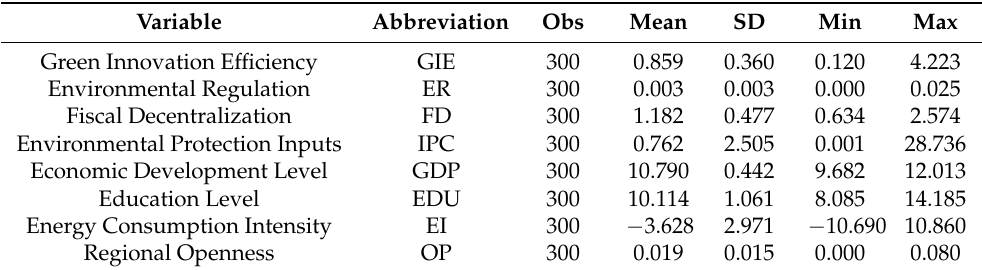
Table 2. Descriptive statistics of study variables.